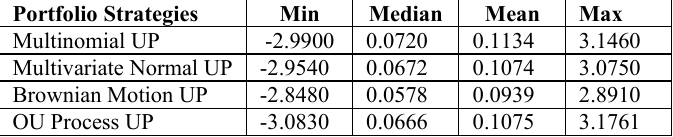
Table 1. Short term duration data analysis (1 year duration ).